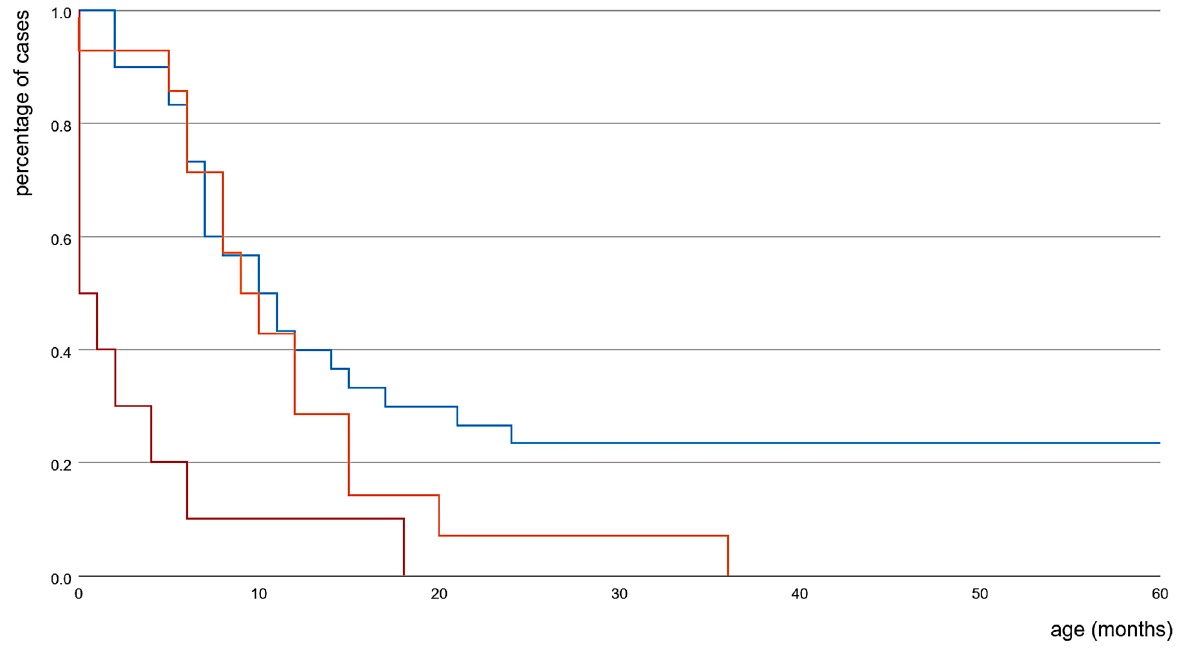
Figure 2. Time-to-Event Curve. Percentage and age of first seizures of the functional subgroups LOF (blue), GOF (orange), and LOF/GOF (red).